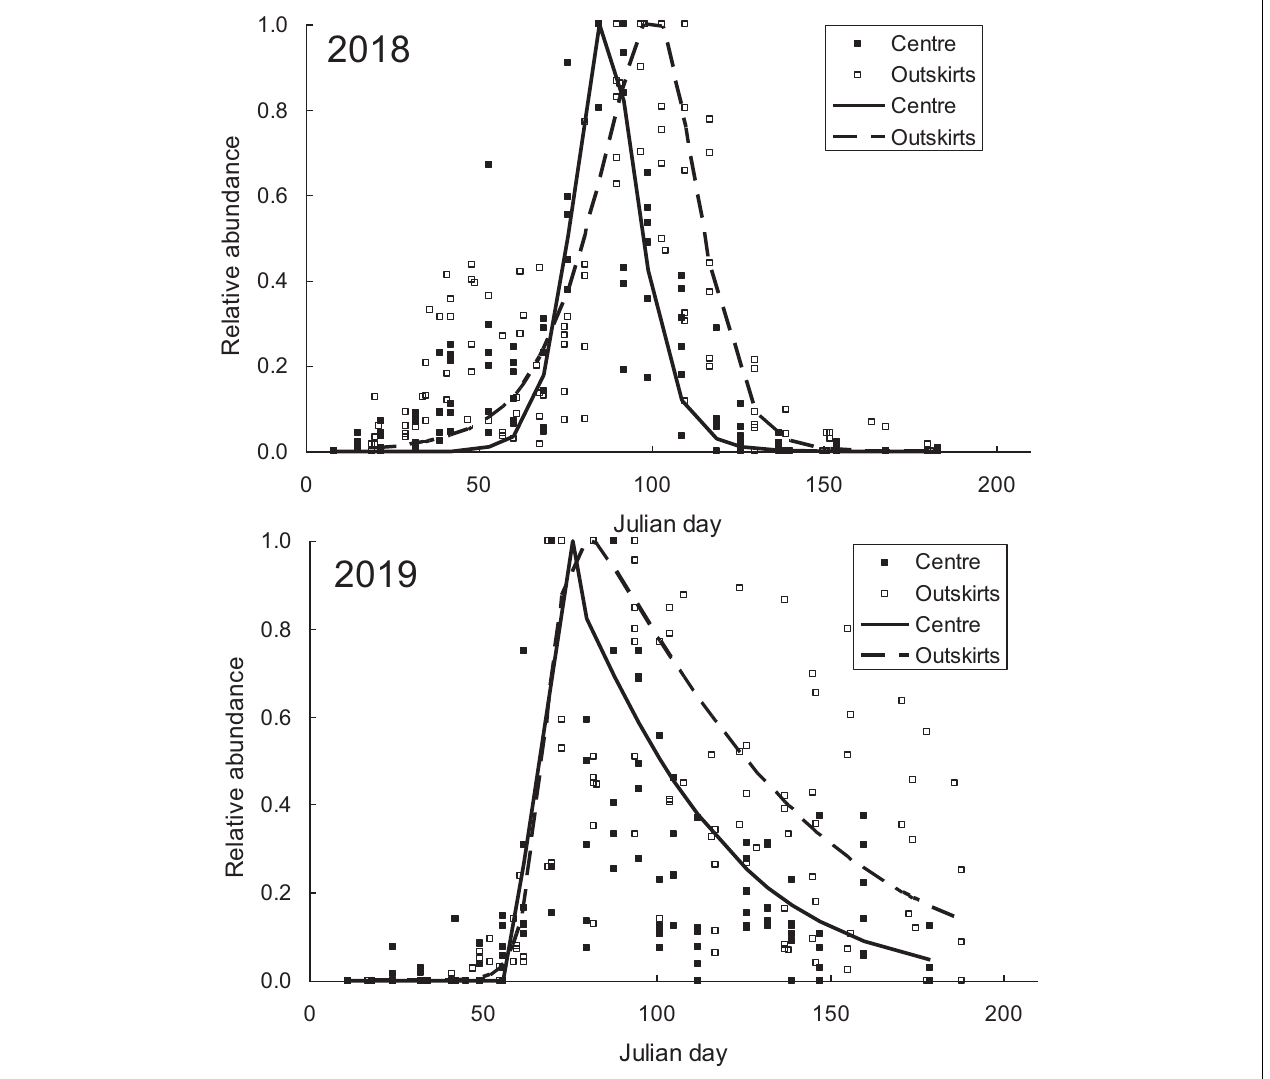
FIGURE 1 | Changes in the relative abundance of Harmonia axyridis in the city center and the outskirts of Prague plotted against calendar time (Julian days from leaving their hibernacula on 20 April). The maximum abundance at each locality is scored 1. The data were fitted to the asymmetric double sigmoidal (ADS) equation. The figure shows example of a year when population peak occurred late in the season (2018) and of a year when population peak occurred early in the season